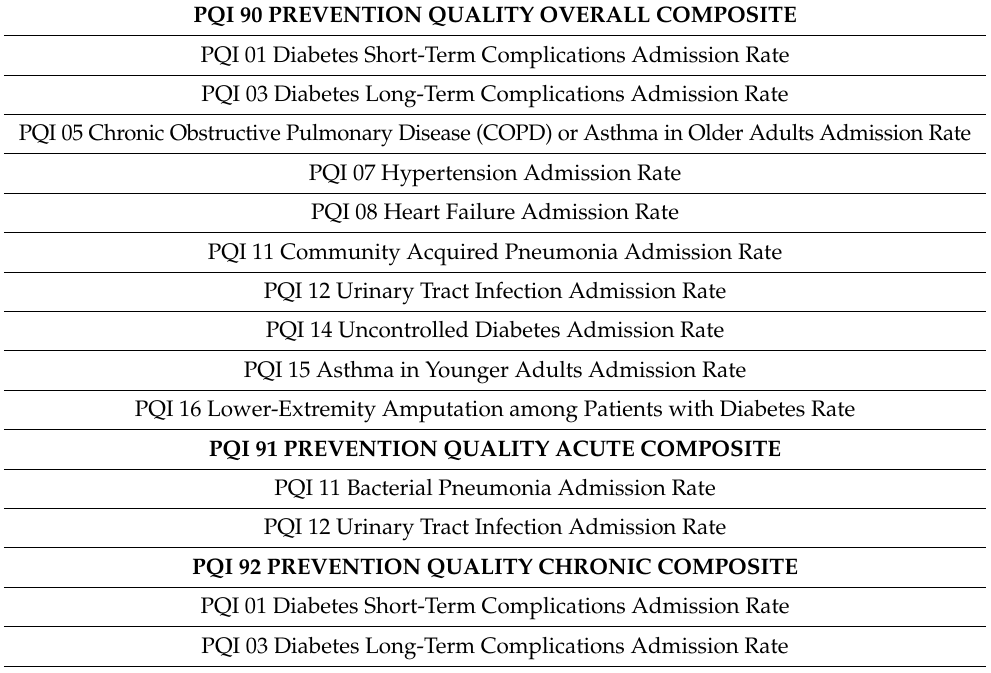
Table A1. AHRQ PQI Composite Measures,